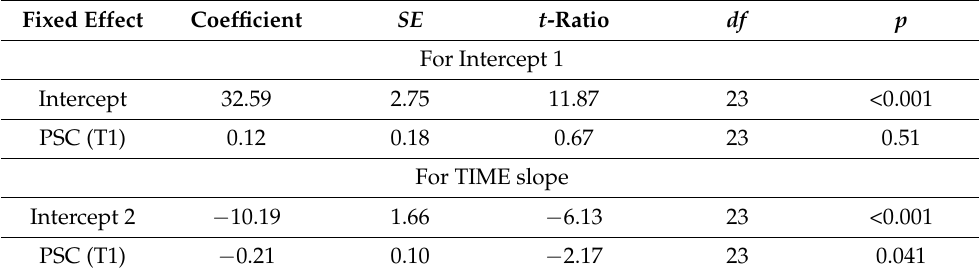
Table 2 (B = − 10.19, SE = 1.66, t = − 6.13, p < 0.001). Therefore, Hypothesis 1 was supported. Table 2. Final estimation of fixed effect; Predicting Change in Psychological